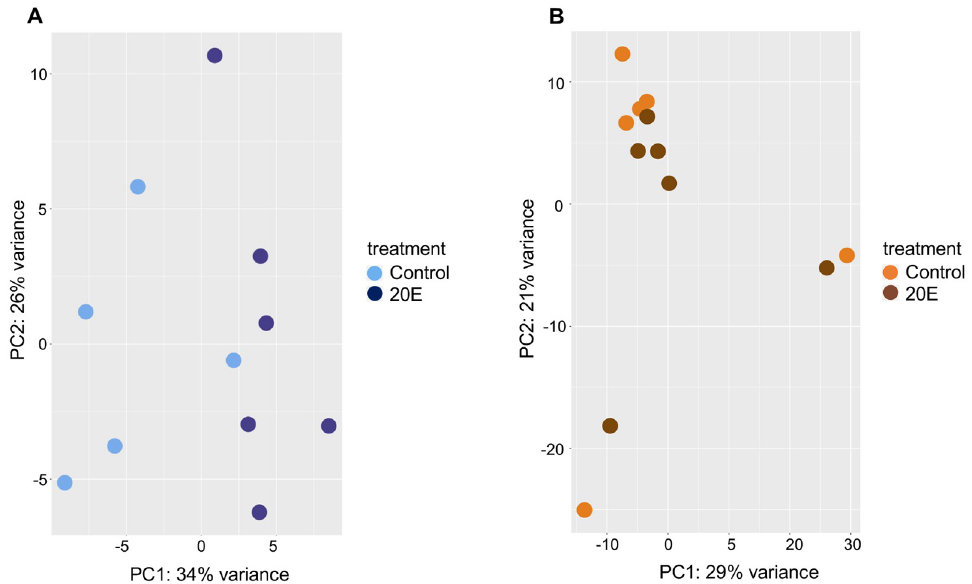
Fig 4. Principal Components Analysis on RNAseq data from midguts from (A) sugar-fed virgin females injected with 20E vs controls with each dot comprising data from a pool of 7 midguts, and (B) on single midguts from virgin females that were injected with 20E vs control and blood-fed on P . falciparum infective blood. All of these samples came from experiment [H] that achieved 80% prevalence after P . falciparum infection.